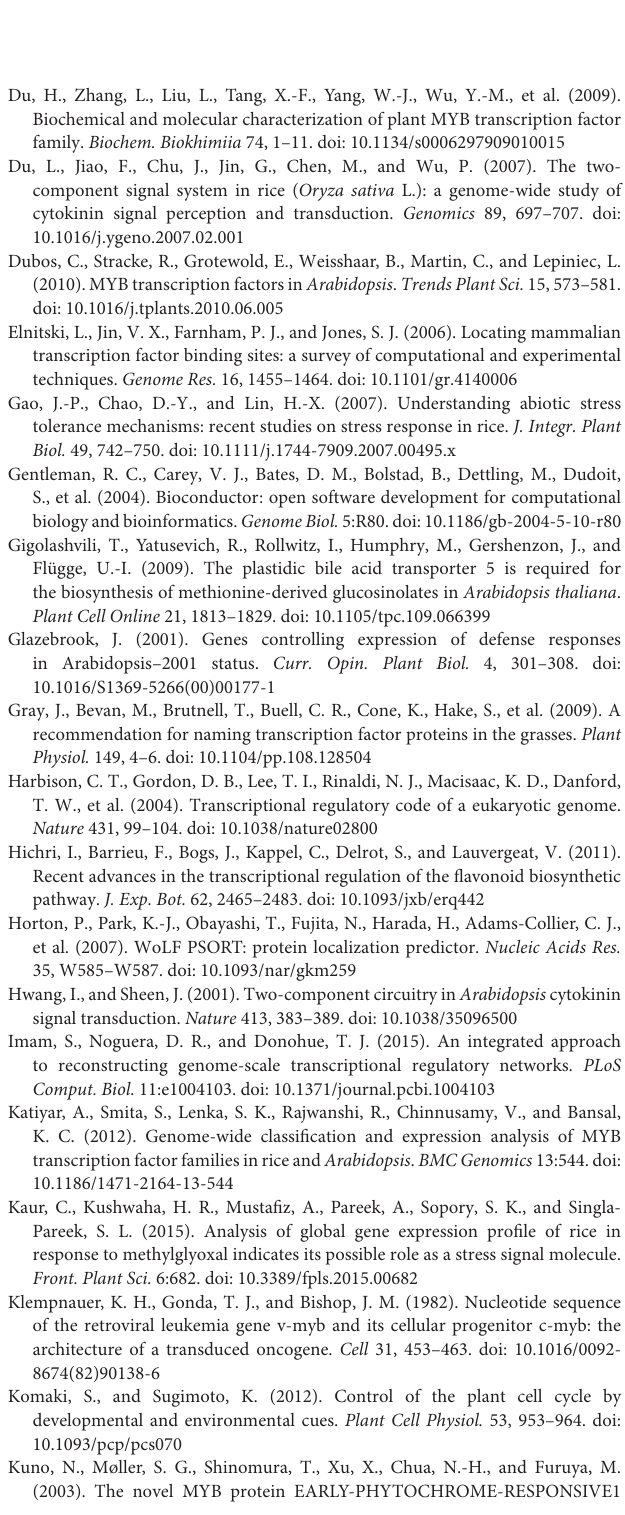
Table S7 | (A) List of guide genes used to create global co-regulatory network via guide-gene approach. ( B ) Global co-regulatory network of guide OsMYB genes and their correlated allies with their description. ( C ) Gene ontology enrichment analysis of target genes.